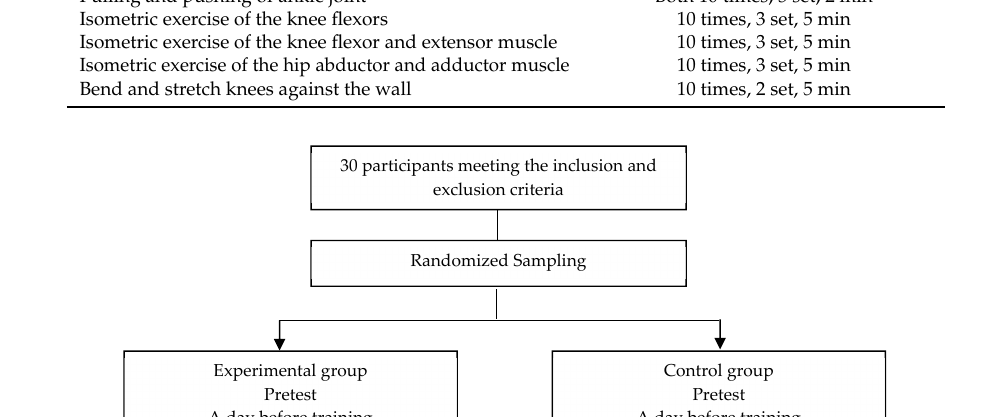
Table 1. Conventional physical therapy program.